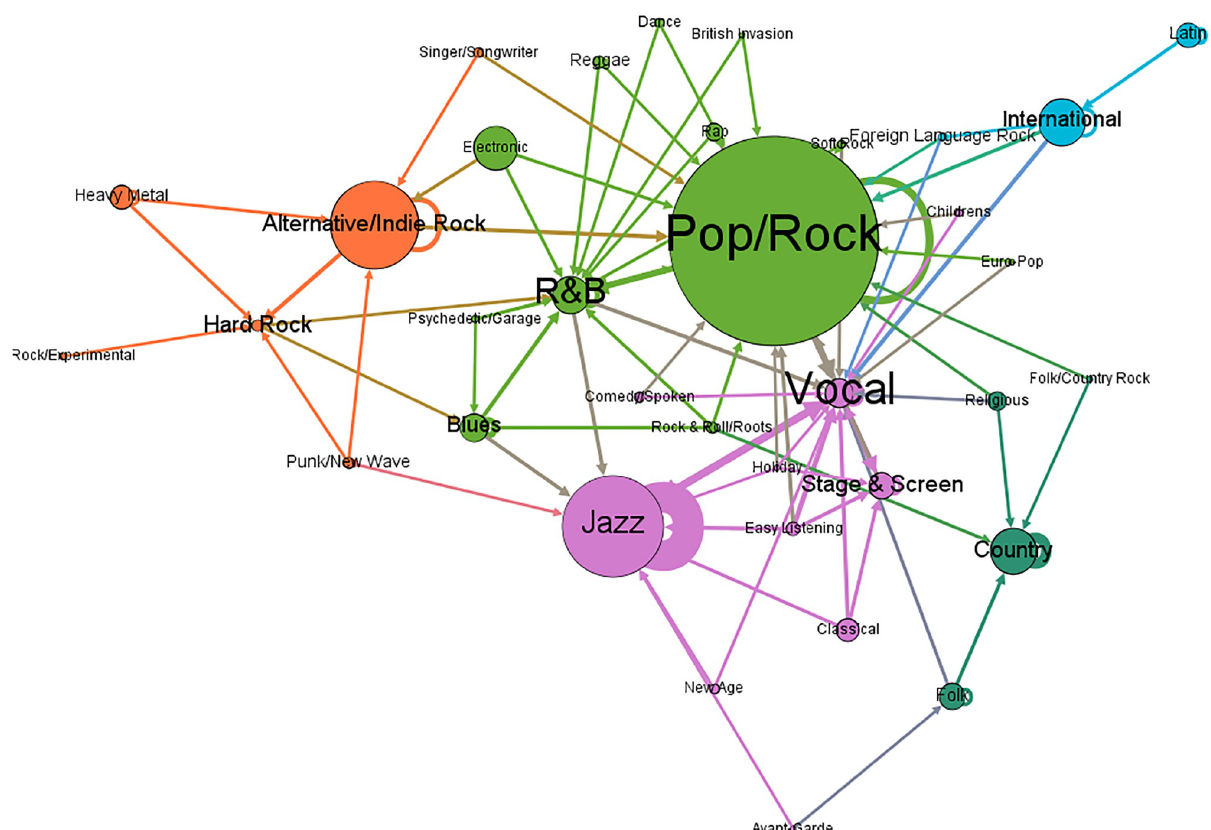
Fig 7. Cover flows between music genres (N = 35) (arcs � 10% of outdegree) (Layout = Yifan